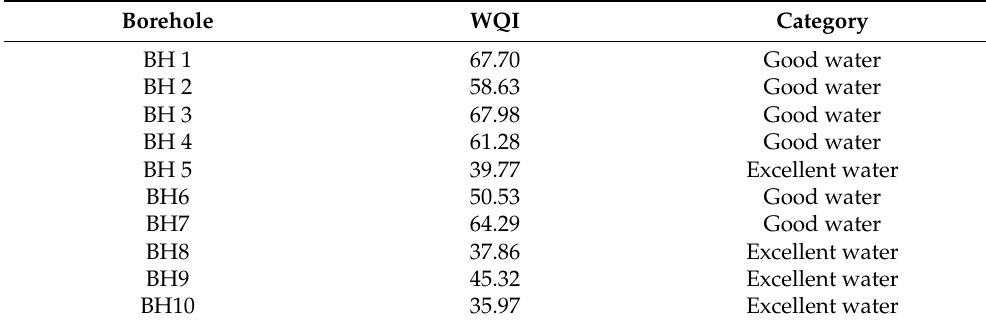
Table 7. Suitability of the groundwater for drinking purposes based on the water quality index